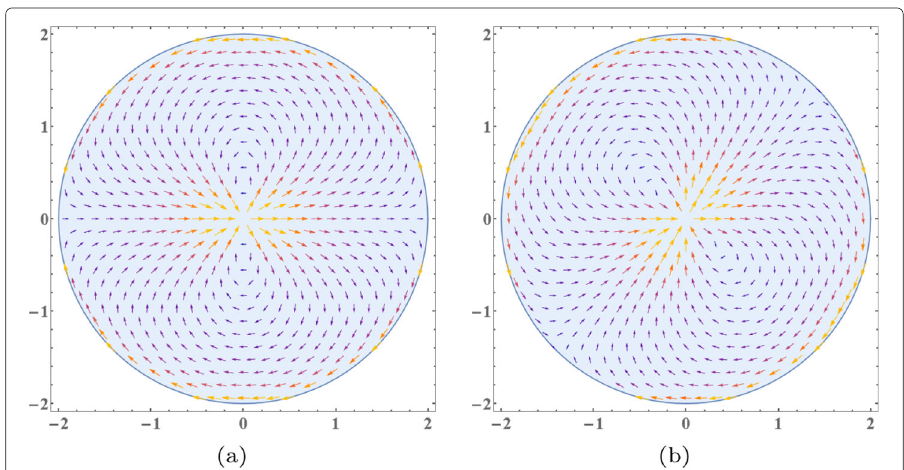
√ Fig. 4 Vector fields ( 1,0 ) · D ( 1,1 ) ( r ) ( a ) and 1 / 2 ( 1,1 ) · D ( 1,1 ) ( r ) ( b ) in homogeneous distributions of loops with radius R = 1. Length and color of the arrows indicate the magnitude of the vectors, qualitatively